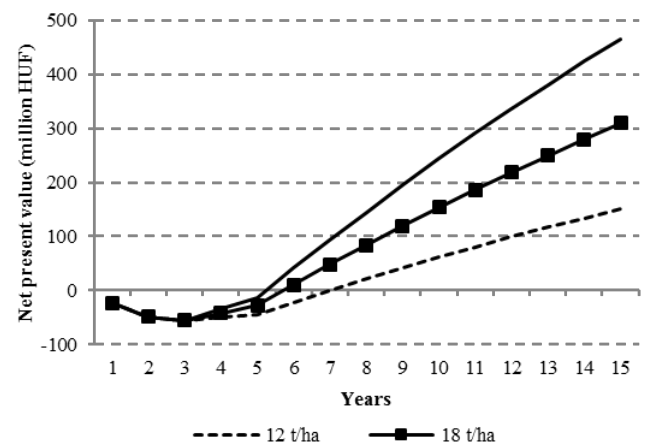
Figure 1. Net present value of the plantation in the case of different average yields Source: Own